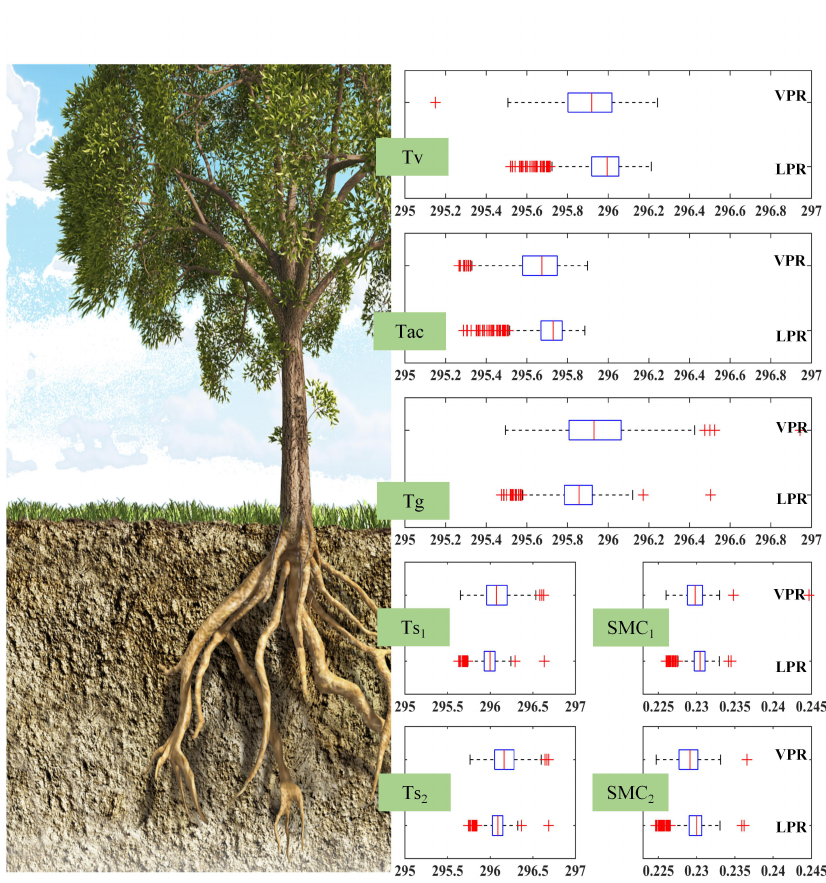
Figure 6. Diagrams for simulated vegetation temperature (Tv), canopy air temperature (Tac), ground temperature (Tg), soil temperature (Ts), and soil moisture (SMC). Red lines indicate the median, the bottom and top edges of the boxes indicate the 25th and 75th percentiles, and red crosses indicate